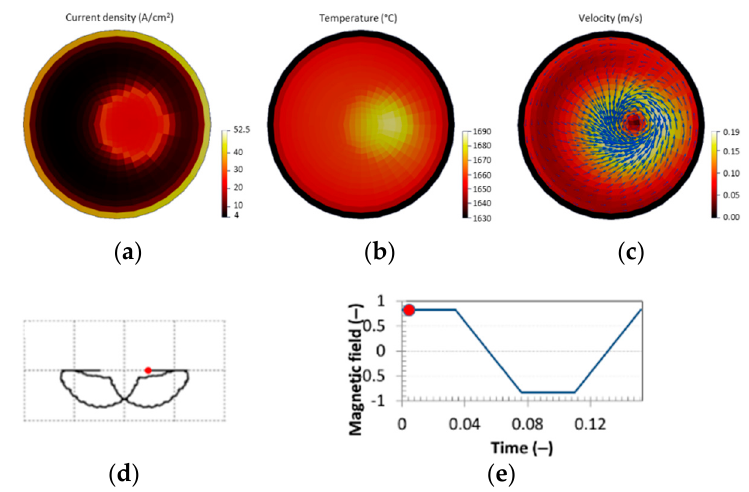
Figure 10. Distributions of ( a ) the current density, ( b ) metal temperature and ( c ) liquid metal velocity in the mesh layer adjacent to the ingot top surface during a plateau of the stirring sequence. ( d ) Orientation of the arc pattern and actual location of the arc centroid. ( e ) Actual time instant along the stirring sequence.